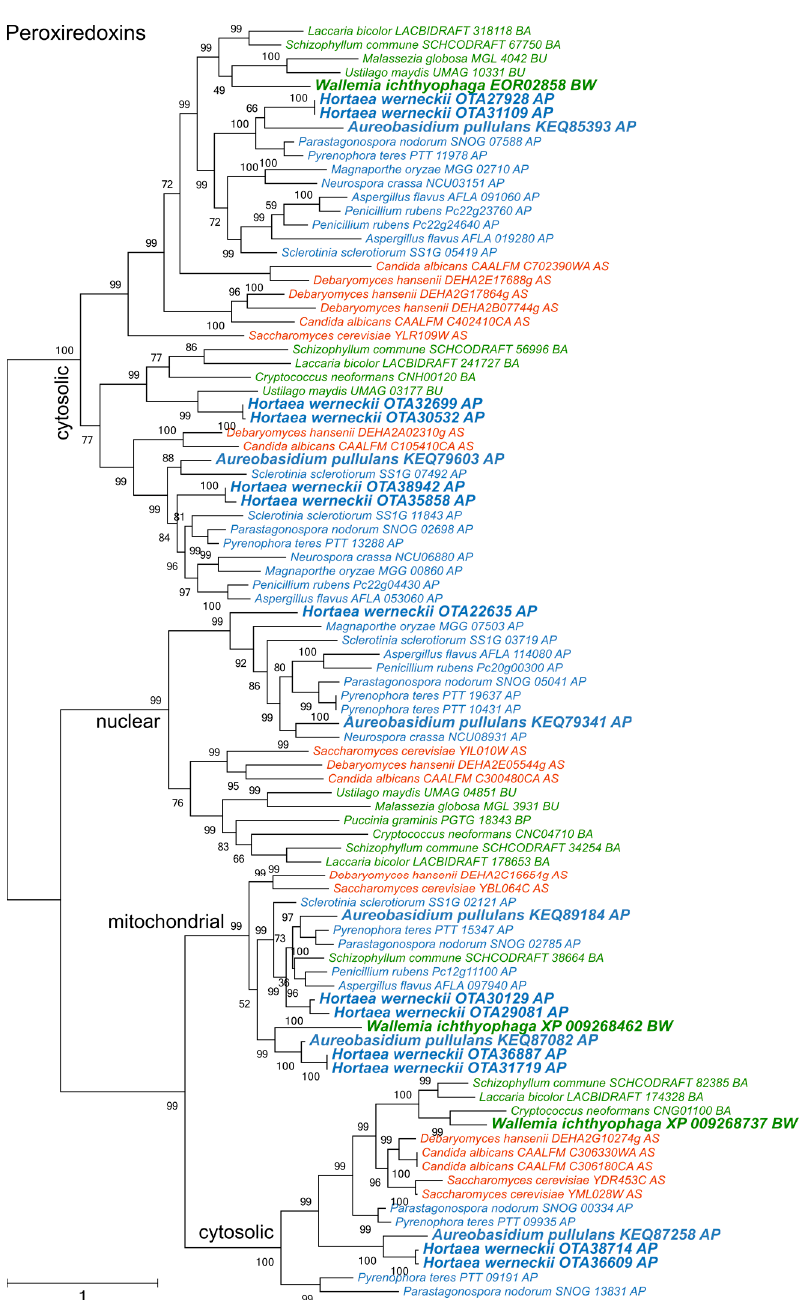
Figure 4. Maximum likelihood phylogeny of genes encoding peroxiredoxins. The phylogeny was